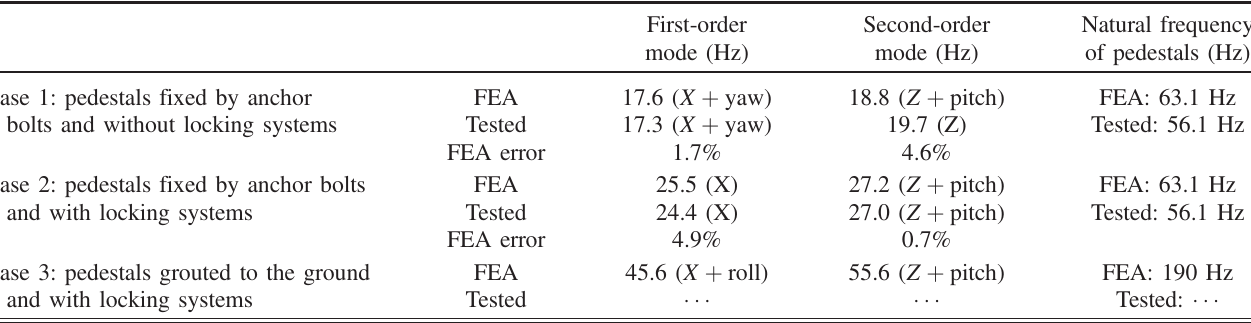
TABLE V. Comparison between FEA results and tested results of the magnet-girder assembly. The directions are defined in Sec. II. “ X þ yaw ” means the mode is a superposition with transition in the X direction and rotation along the Y axis. And others in a similar